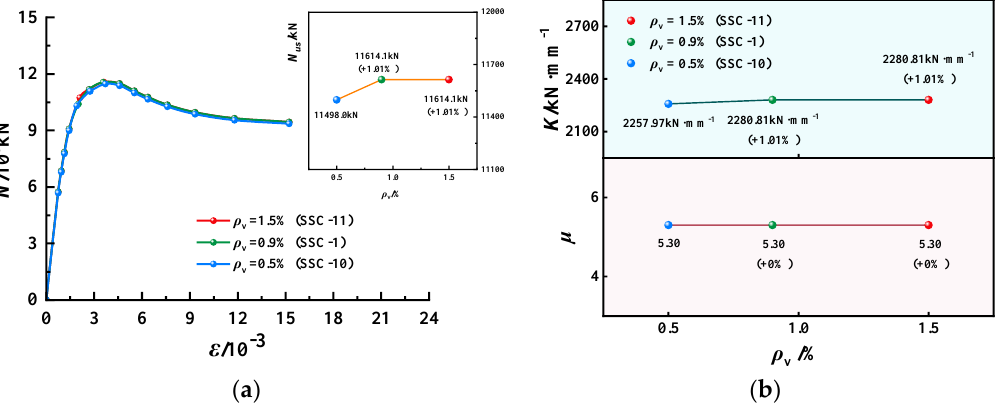
Figure 13. N - ε curves, K and µ of EGCSSCs with different ρ v : ( a ) N - ε curves of specimens with cross-section height of 800 mm. ( b ) K and µ of specimens with cross-section height of 800 mm.